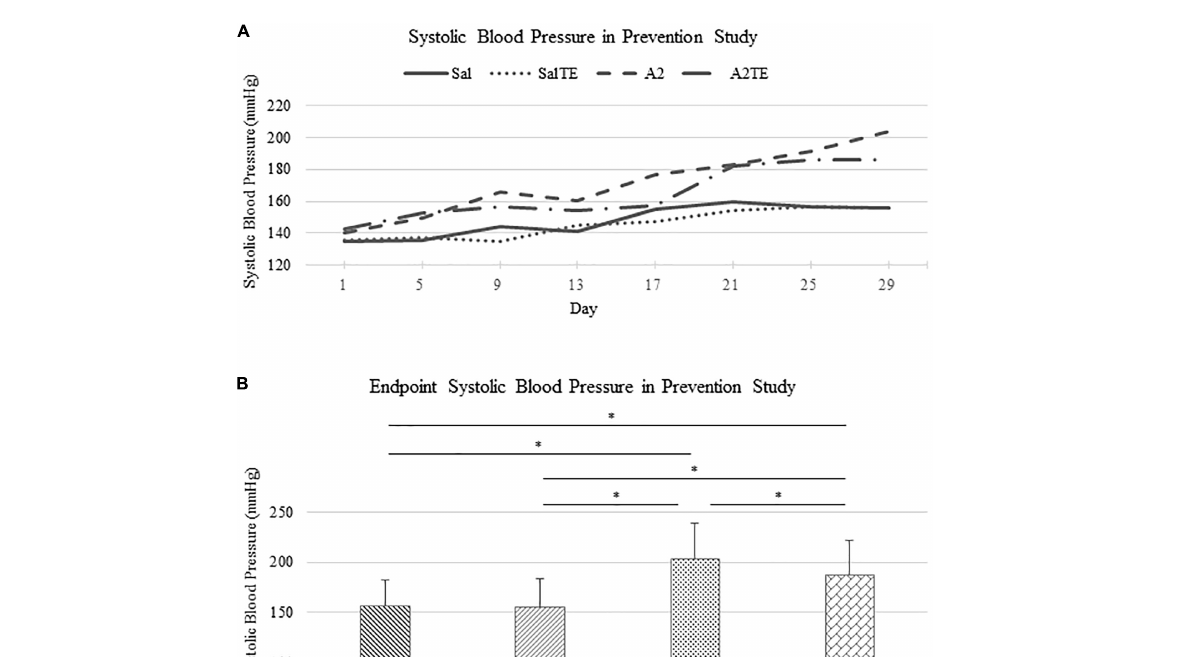
FIGURE2 (A) Systolic blood pressure changes with time in hypertensive and normotensive mice in prevention study. (B) Endpoint (Day 29) systolic blood pressure comparison across treatments. Asterisk indicates significant difference ( p < 0.05).